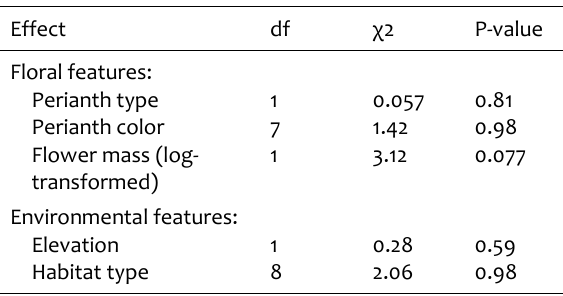
Table 1. Results of the phylogenetic regression across plant species ( N = 251) testing for the effects of perianth type and color, flower mass, elevation and habitat type, on mean flower visitation probability by nitidulid beetles while simultaneously accounting for the significant phylogenetic correlation underlying flower visitation